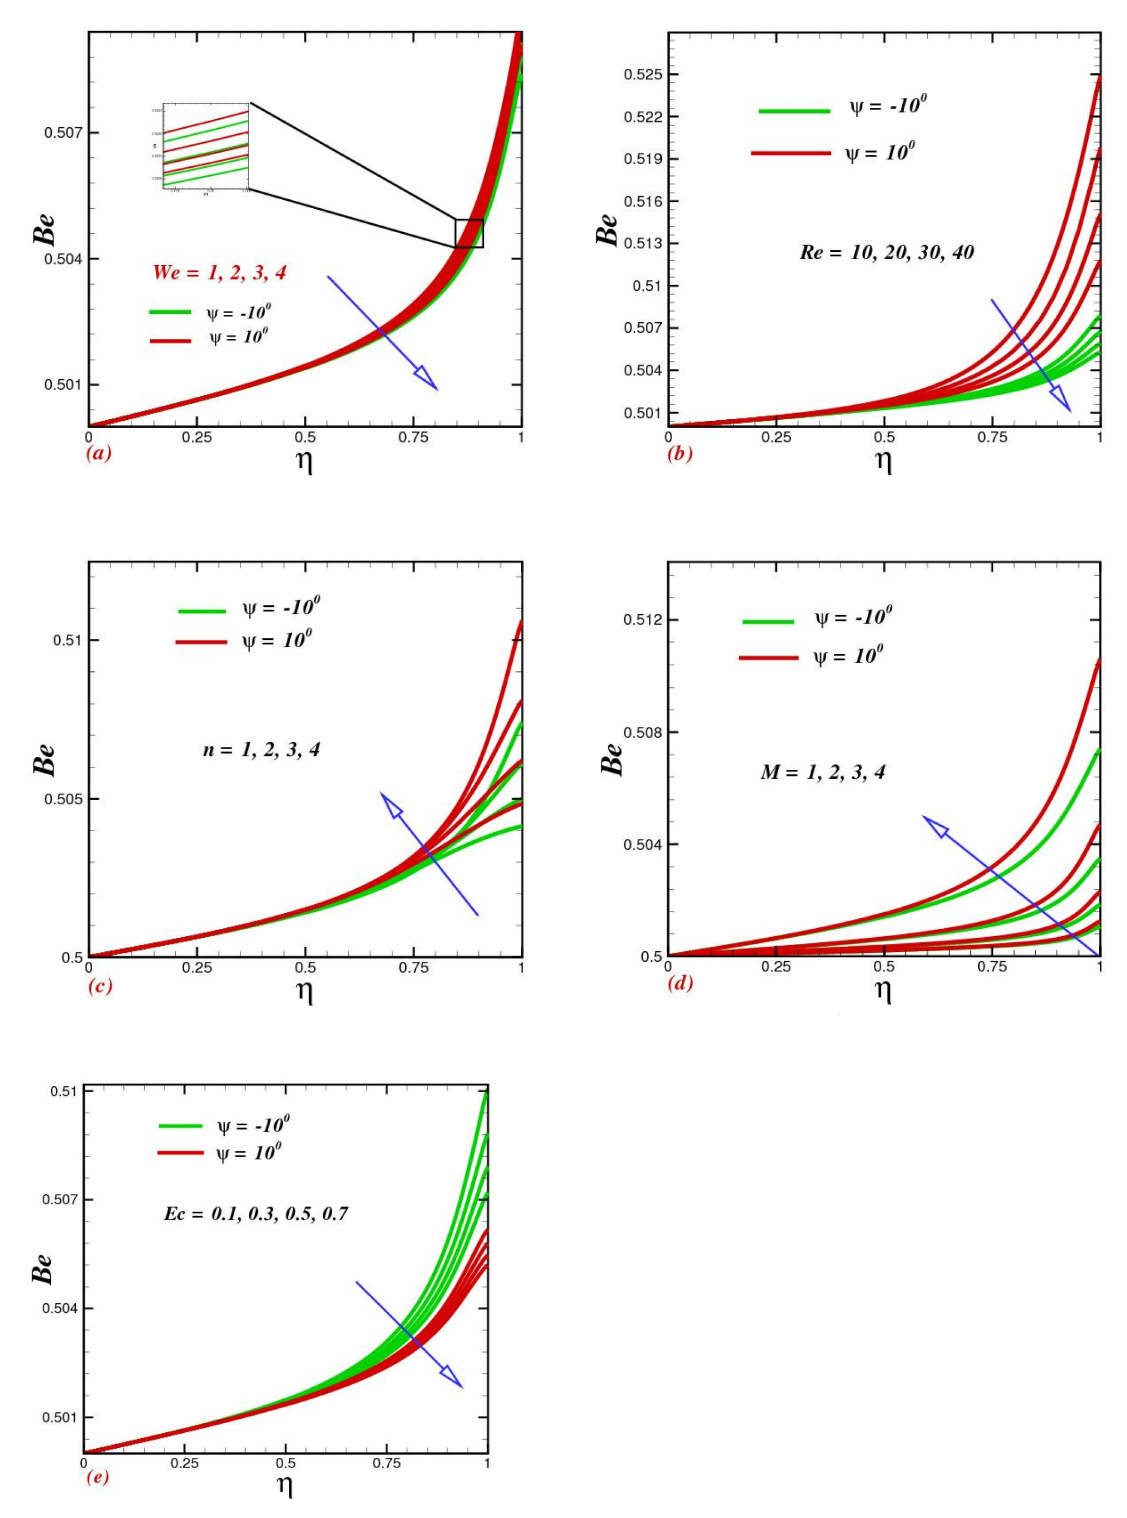
Figure 8. ( a ) Impacts of the Weissenberg number We , ( b ) Reynolds number Re , ( c ) power-indexed parameter n , ( d ) magnetic parameter M , and ( e ) Eckert number Ec on the Bejan profile Be